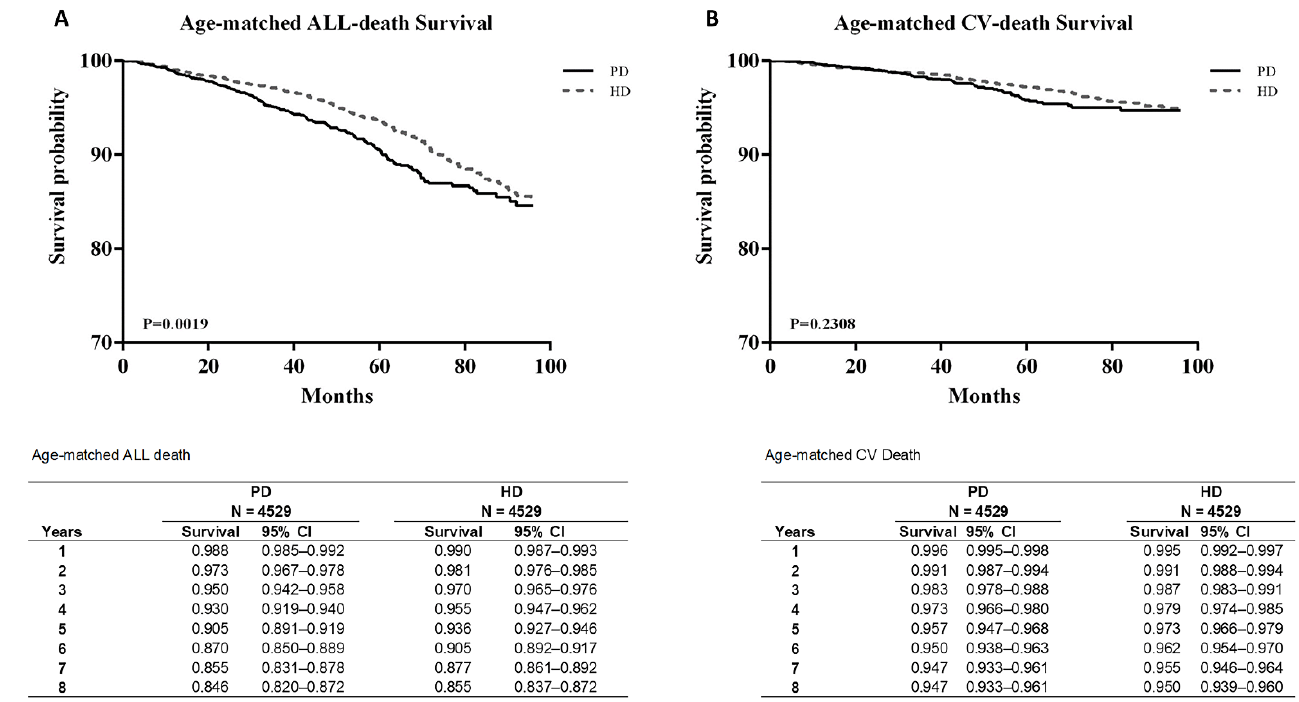
Figure 3. Age-matched survival curves between all-death survival ( A ) and CV-death survival ( B